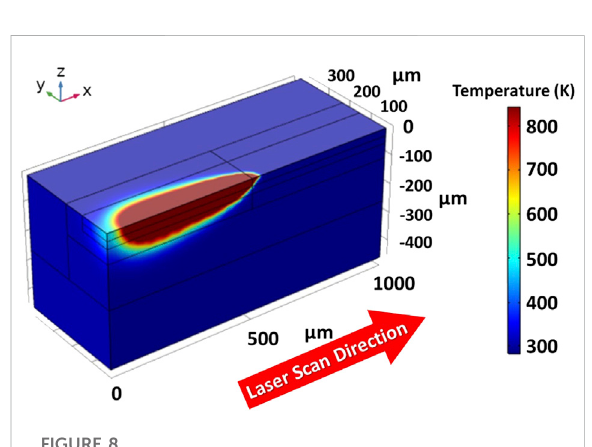
FIGURE 8 Typical visualization of the temperature gradients (and thus indirectly the melt pool) in the simulations. In the instance shown, process parameters were 25 W and 350